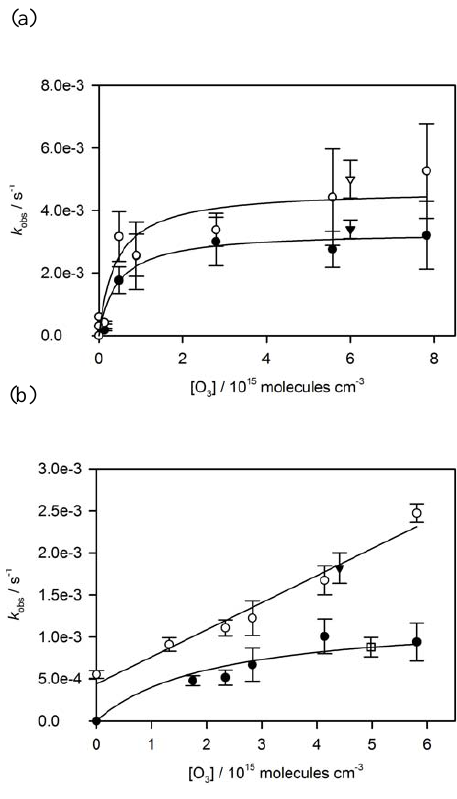
Fig. 3. Heterogeneous loss rate of pyrene at the (a) air-solid film and (b) air-aqueous interface as a function of gas-phase ozone con- centration. The solid circles represent the dark reaction while the hollow circles represent the light reaction. In (a) , the inverted tri- angles represent the current experiments; all other data is adapted from Styler et al. (2009). The inverted solid triangle in (b) repre- sents experiments performed using a 320nm long-pass optical fil- ter; all other experiments were performed using a 295nm filter. The hollow square in (b) represents experiments performed at the sur- face of five times more dilute aqueous pyrene solutions under dark conditions. All experiments were performed at room temperature and atmospheric